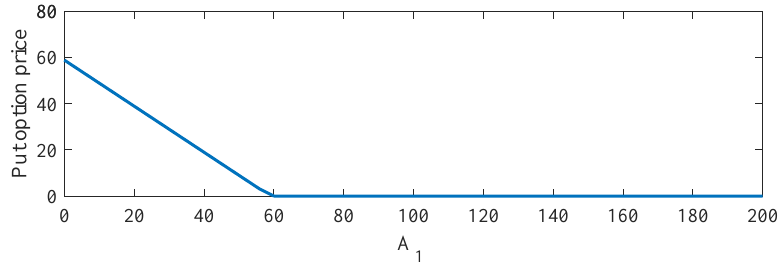
Figure 2. The solution plots of the European put option obtained from the Black–Scholes model with ce 0 two stock prices for A 2 = 8.